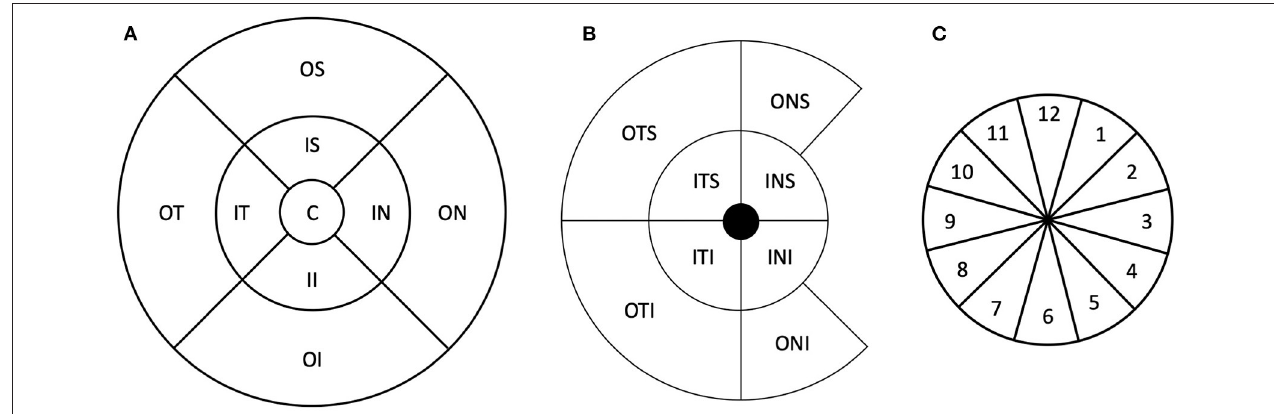
FIGURE 1 | Schematic representation of the thickness maps used in this study. (A) Early Treatment Diabetic Retinopathy Study sector map. (B) Ganglion cell complex map. (C) Schematic representation of the peripapillary retinal nerve fiber layer thickness sectors. The numbers represent the clock hour positions. C, central; IS, inner superior; OS, outer superior; IN, inner nasal; ON, outer nasal; II, inner inferior; OI, outer inferior; IT, inner temporal; OT, outer temporal; ITS, inner temporal superior; INS, inner nasal superior; INI, inner nasal inferior; ITI, inner temporal inferior; OTS, outer temporal superior; ONS, outer nasal superior; ONI, outer nasal inferior; OTI, outer temporal